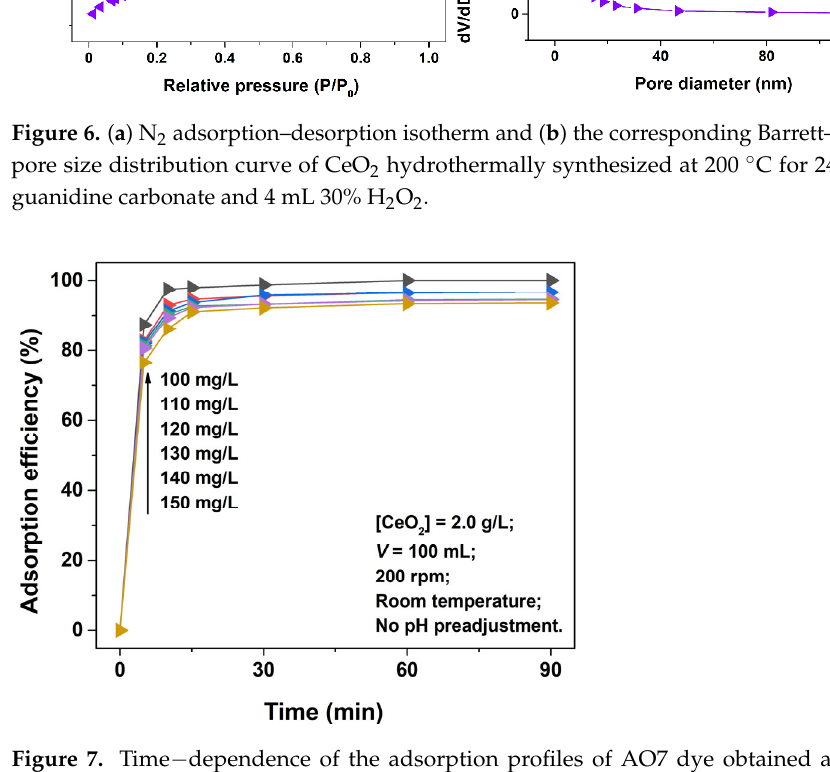
( K F ) parameters calculated are listed in the insets in Figure 8a,b. The Langmuir isotherm